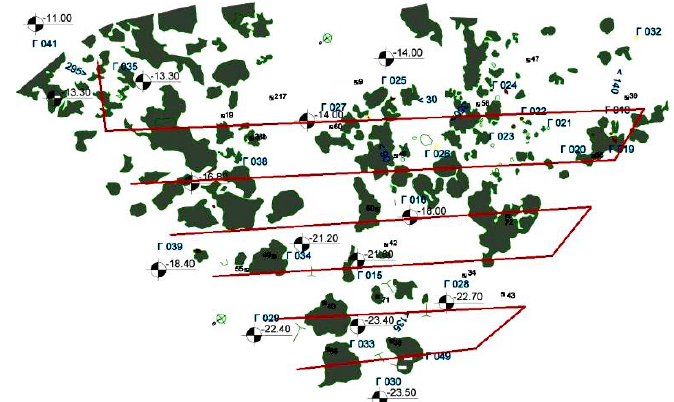
Figure 4: Preparation of the first basic concentration